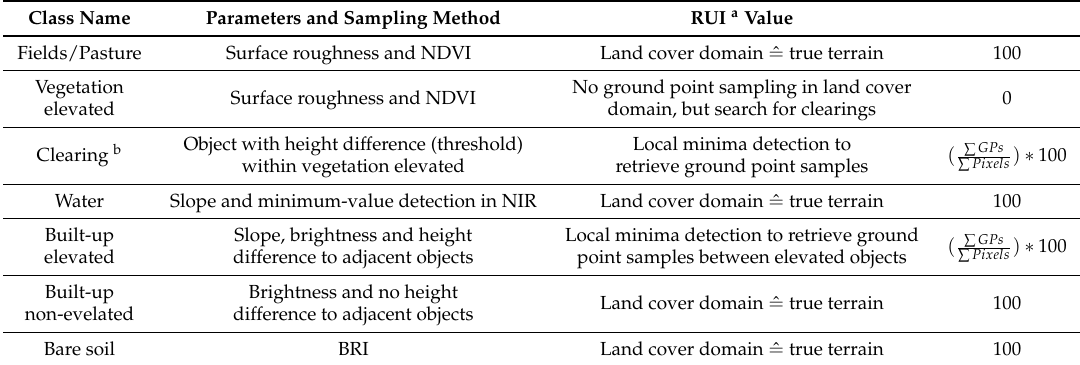
Table 1. Class names adapted from Lohmann [31], extraction features applied in the approach, respective methods for DEM sampling and regional uncertainty index value